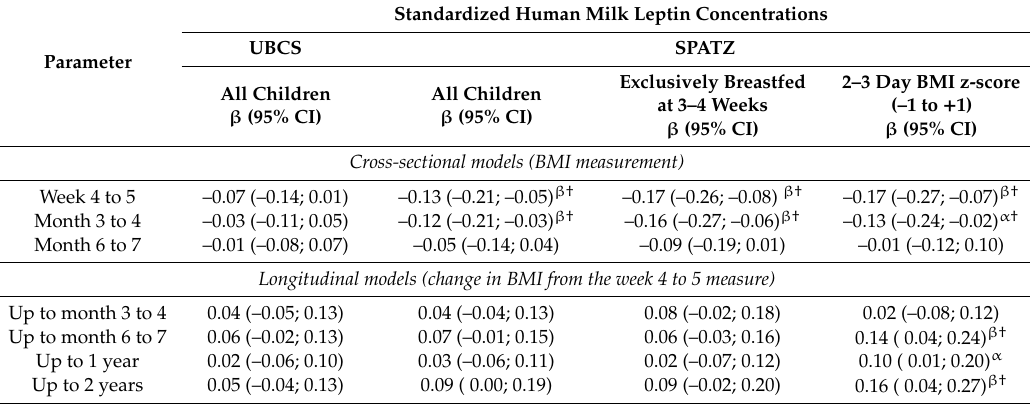
Table 3. Adjusted* beta coe ffi cients and 95% confidence intervals for the association between 6 week human milk leptin concentration z-score and child BMI or change in BMI z-scores up to age 2